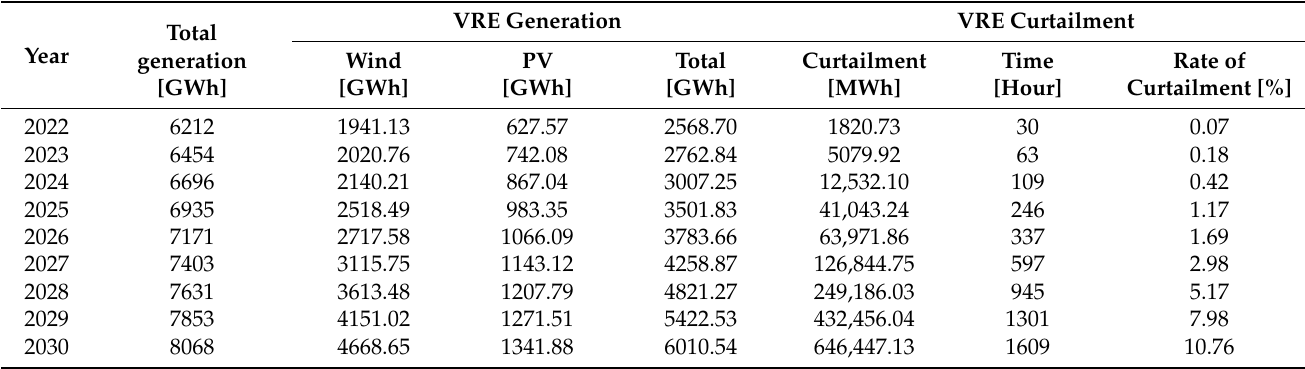
Figure 6. The duration curve of the net load in Jeju from 2022 to 2030. Table 8. Amount of curtailment for each year.